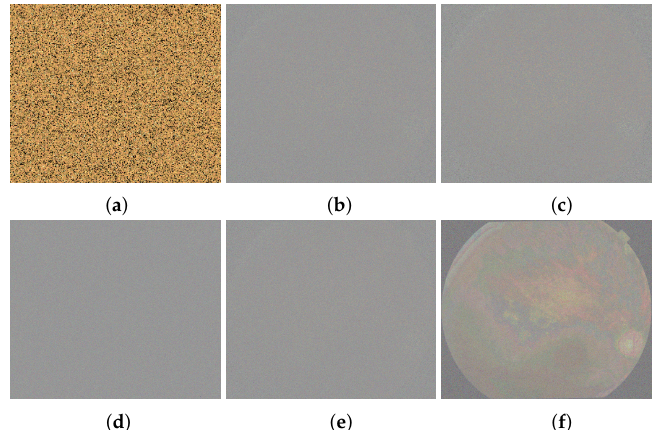
Figure 18. Correlation distributions of image number 15 (sick patient). ( a ) Wrong key for the first Jigsaw transform. ( b ) Wrong key for the first deterministic noise. ( c ) Wrong key for the cyclic permutation. ( d ) Wrong key for the second Jigsaw transform. ( e ) Wrong key for the second deterministic noise. ( f ) Wrong key for Langton’s